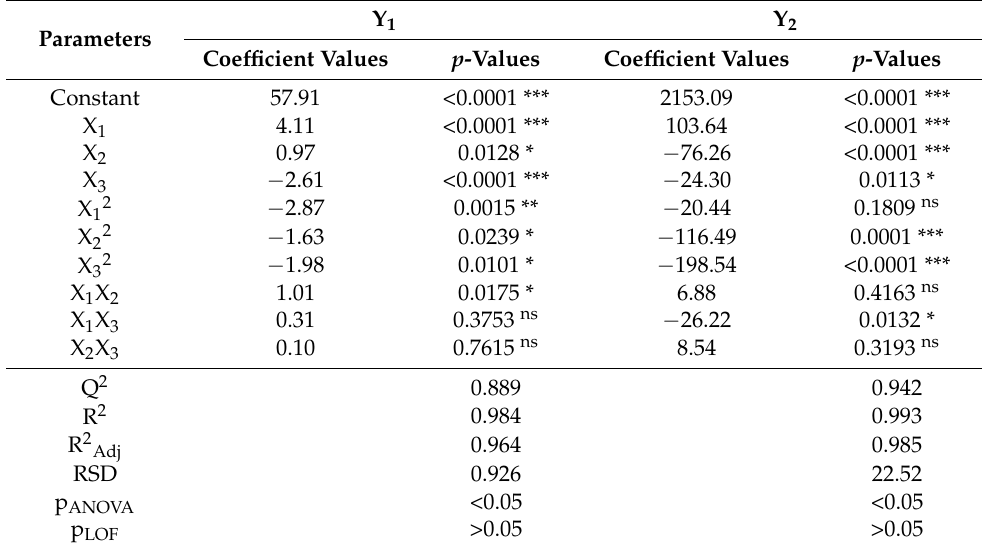
Table 3. Estimated regression coefficients and variance analysis results for response